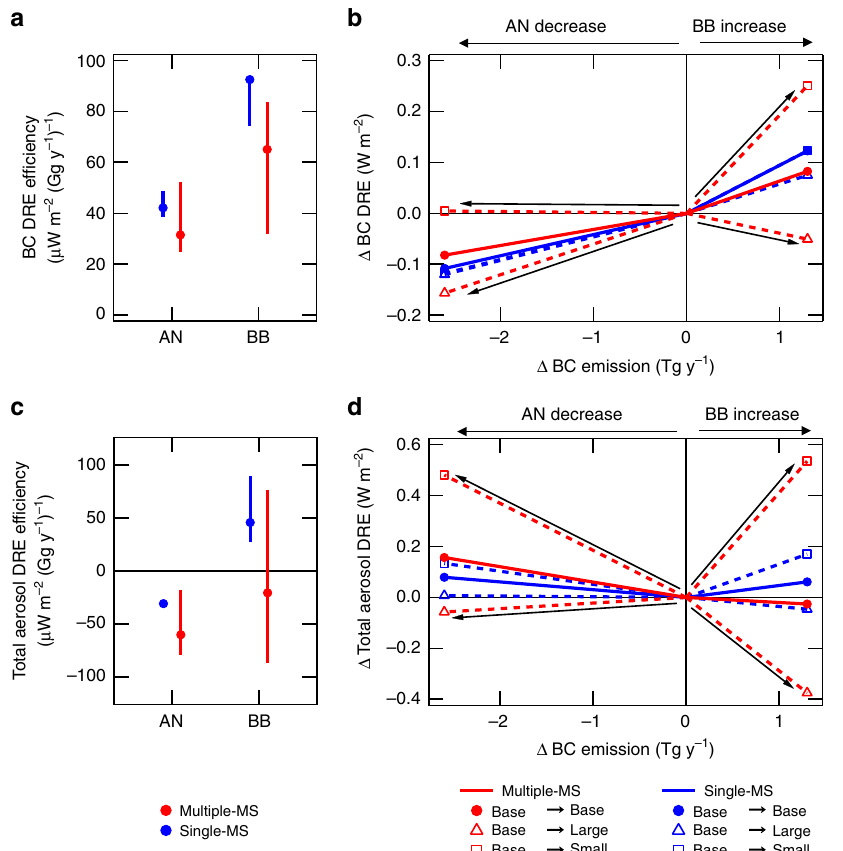
Fig. 6 Sensitivity of direct radiative effect to emission changes in the future. a, c Direct radiative effect (DRE) ef fi ciency (see Methods) is shown for ( a ) black carbon (BC) and ( c ) total aerosols (sum of BC, organic aerosol, sulfate, and nitrate) for anthropogenic (AN) and biomass burning (BB) sources. Vertical bars show the maximum-minimum ranges of the Base-size, Small-size, and Large-size simulations. The values for the Base-size simulations are shown by circles. b, d Responses of ( b ) BC and ( d ) total aerosol DRE to changes in AN and BB emission fl uxes. Changes in DRE when emission size distributions (for all sources) are changed from the Base-size (present-day) to the Base-size, Small-size, and Large-size (future) are shown by closed circles, open squares, and open triangles, respectively. Total aerosol DRE and its ef fi ciency in ( c ) and ( d ) are calculated with the scaling of BC and non-BC radiative forcing to radiative forcings in Myhre et al. 3 (see